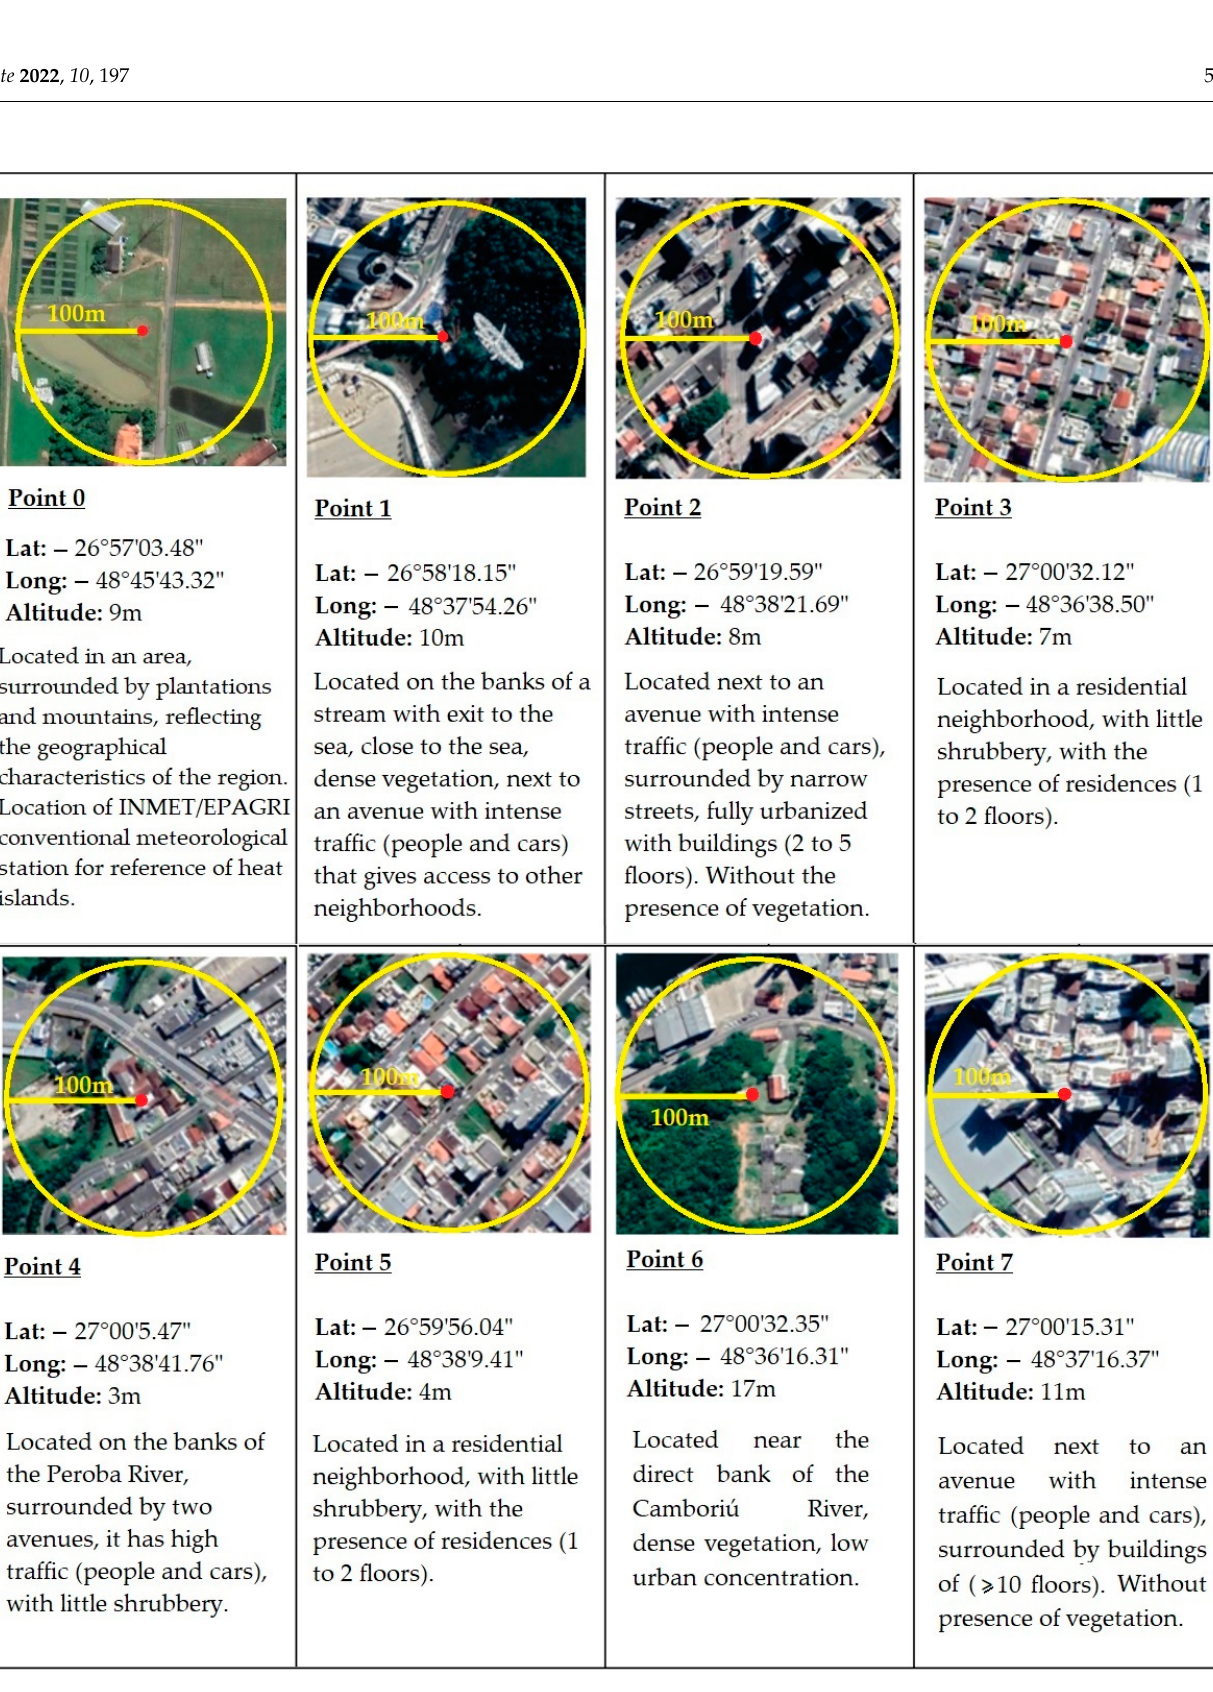
Figure 3. Characteristics of the points selected for the survey. Source: Google Images. Elaborated by the authors (2022).